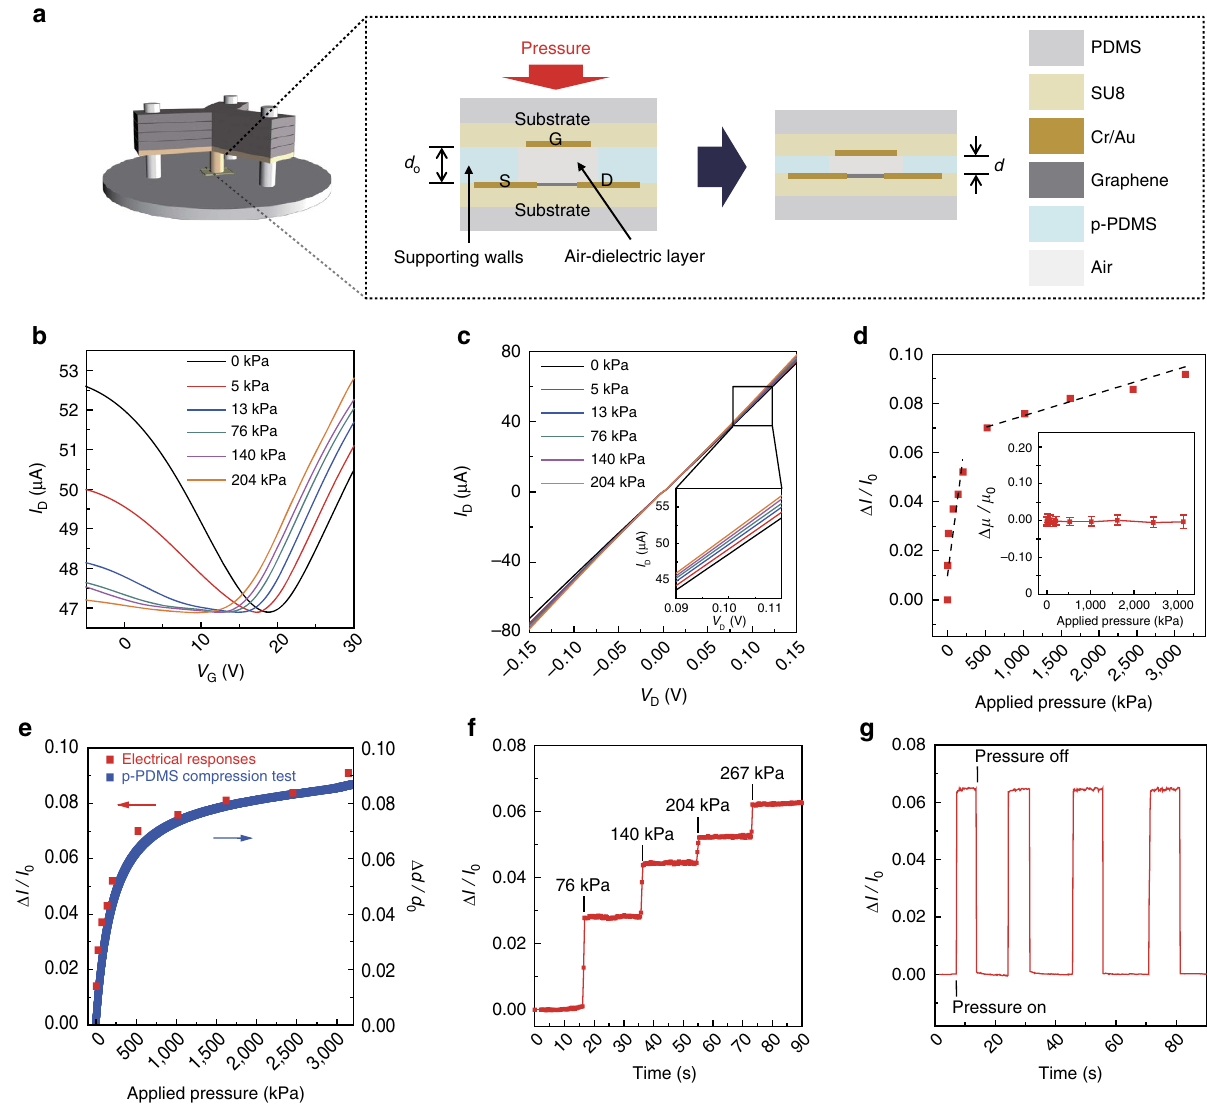
Figure 2 | Electrical responses of graphene FETs to the applied pressures. ( a ) Schematic illustrations for the pressure sensing mechanism using an air-dielectric graphene FET. ( b , c ) Electrical responses of FETunder different amount of applied pressures. Transfer characteristics ( V D ¼ 0.1V) ( b ). Output characteristics ( V G ¼ 25V) ( c ), respectively. ( d ) Plot of normalized drain current changes versus applied pressure. The inset illustrates relative change in the field effect mobility under applied pressure until B 3MPa showing almost constant values (error bars indicate the standard deviations calculated from the 1,000 times cyclic pressure loading test). ( e ) Comparison between electrical responses of the fabricated pressure sensor and true stress-strain curve from p-PDMS film compression test. ( f , g ) Real-time measurements of normalized drain current changes for applied pressures at V D ¼ 0.1V and V G ¼ 25V. The different amounts of pressure are stacked one by one sequentially representing step-like features ( f ). Pressure (267kPa) is loaded and unloaded repeatedly to evaluate stable and reliable operation ( g